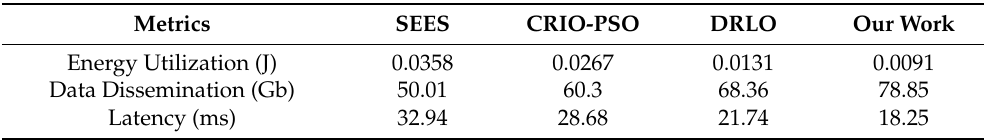
Table 2. Comparative analysis for varying time